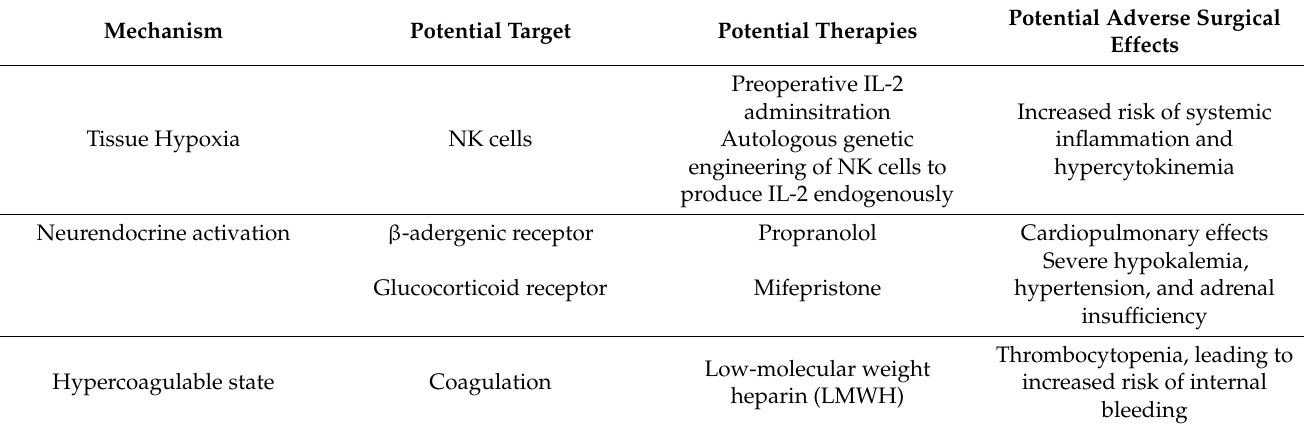
Table 1. Potential therapeutics to target postoperative Natural Killer cell